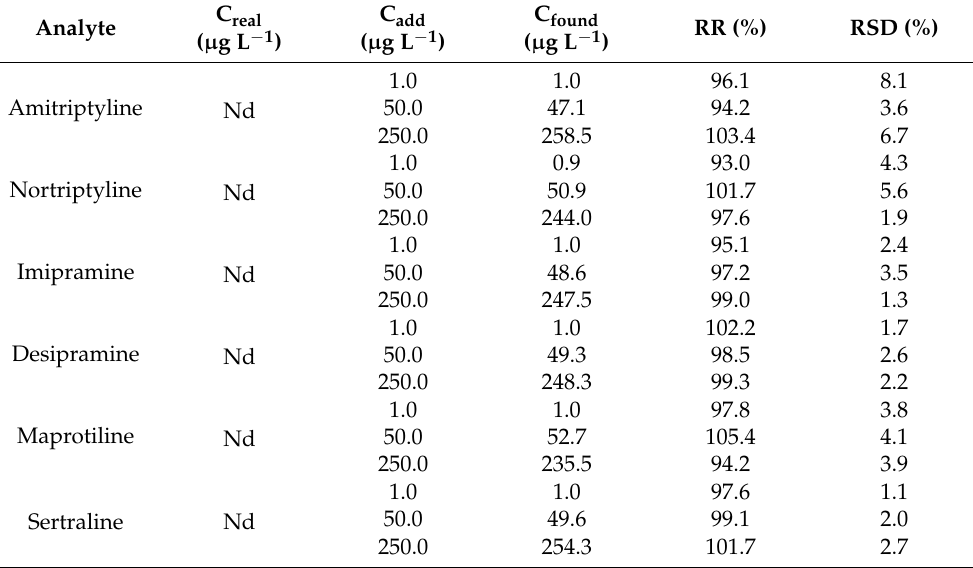
Table 6. Obtained results from the determination of TCAs in well water sample spiked at three different concentration